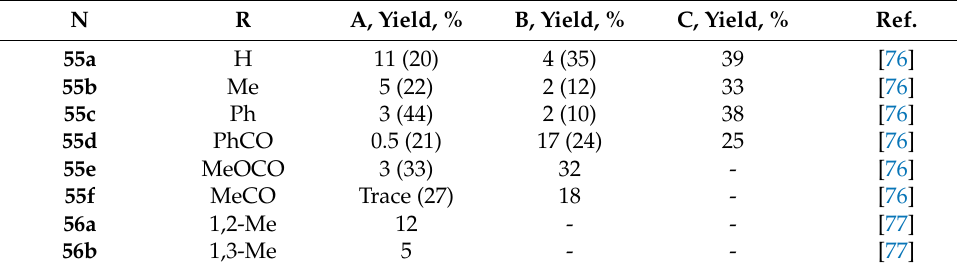
55d PhCO 55e MeOCO 3 (33) 55f MeCO Trace (27) 56a